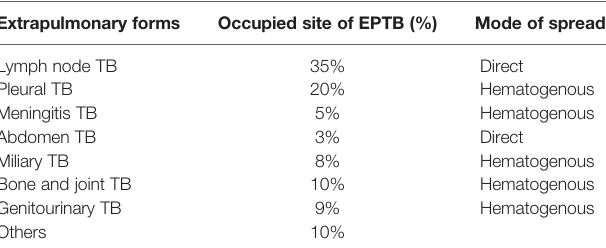
TABLE 1 | The bacterial manifestation reported at the surplus site and the prepotency. Extrapulmonary